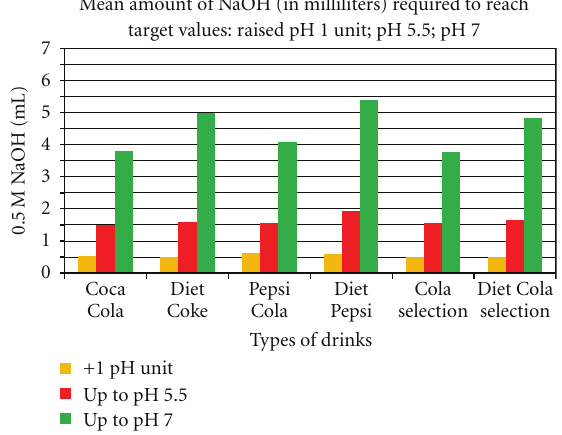
Figure 2: Bu ff ering capacities of pop-Cola drinks for a single unit pH change (orange) to critical pH 5.5 (red) and pH 7 (Green). The orange bars show Pepsi Cola having the highest bu ff ering capacity while Diet-Coke and Selection Cola share the lowest bu ff ering capacity. The red bars show bu ff ering capacities for change from the drink’s initial pH up to the critical pH 5.5, with Diet Pepsi having the highest bu ff ering capacity (1.9mL of 0.5M NaOH) while Coca Cola has the lowest bu ff ering capacity (1.5mL of 0.5M NaOH). The green bars show bu ff ering capacities for a pH change from the drink’s initial pH up to neutral (pH 7.0). Diet Pepsi has the highest bu ff ering capacity (5.38mL of 0.5M NaOH), regular Selection Cola (3.78mL of 0.5M NaOH) has the lowest bu ff ering capacity, and Coca Cola (3.79mL of 0.5M NaOH) is very similar and not significantly di ff erent from Selection Cola. All the cola- drinks absorb the alkali but vary in the amount of alkali to reach pH 7.